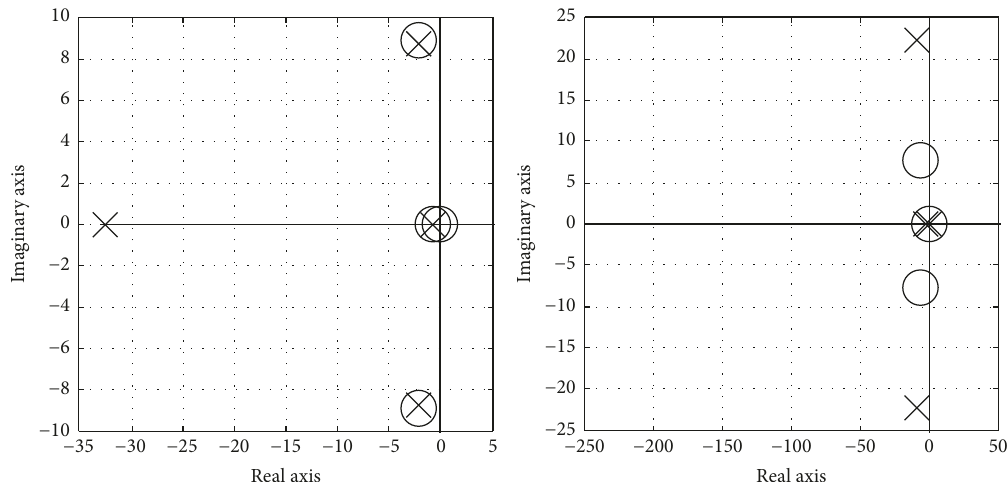
Figure 8: Conventional robust H ∞ control for vehicle body lateral acceleration. (a) Without perturbation. (b) With perturbation.